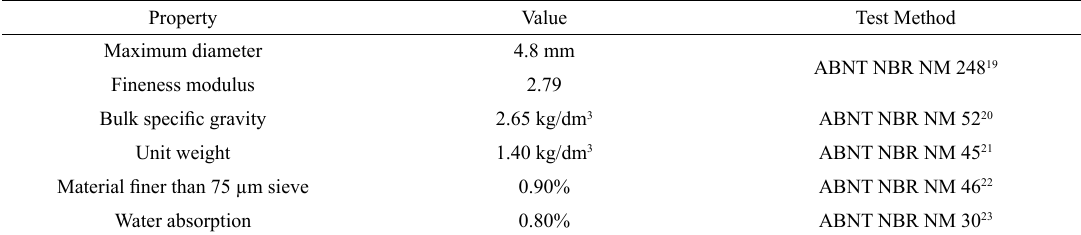
Table 3. Sand properties.